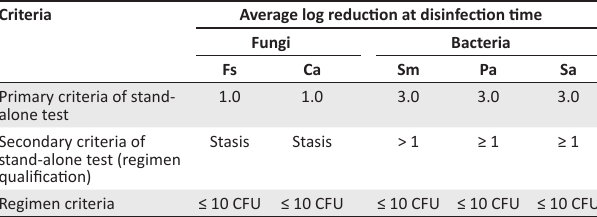
TABLE 1: The required average log reduction at disinfection time according to ISO standards.